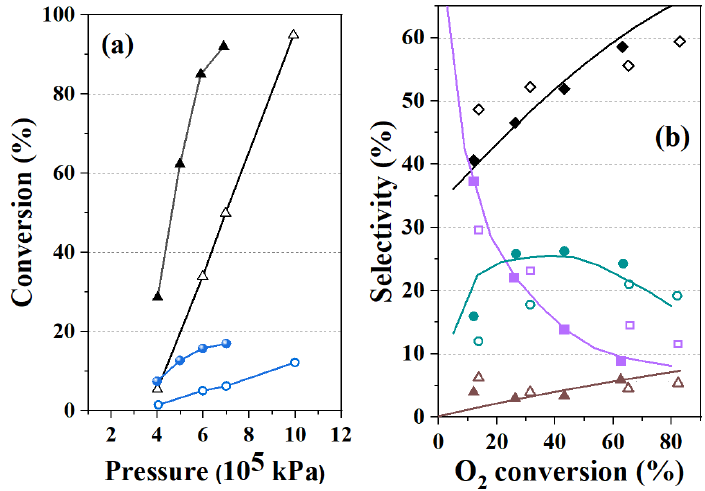
Figure 11. ( a ): Pressure effect on O 2 ( ∆ , ▲ ) and CH 4 ( ● , ○ ) conversions at 817 °C and inlet CH 4 /O 2 molar ratio equal to 10 (empty symbols) and equal to 5 (filled symbols). ( b ): Carbon selectivities for C 2 H 4 ( ● , ○ ), C 2 H 6 ( ■ , □ ), CO ( ◊ , ♦ ), and CO 2 ( ∆ , ▲ ) at 1 atm and 827 °C (filled symbols and solid lines), and at 4 atm at 805 °C (empty symbols), for inlet CH 4 /O 2 molar ratio equal to 4 [97]. Continuous lines are for visualisation only. Table 4. Reaction steps considered in the kinetic model proposed by Stansch et al. [92] to describe OCM in the presence of a La 2 O 3 /CaO